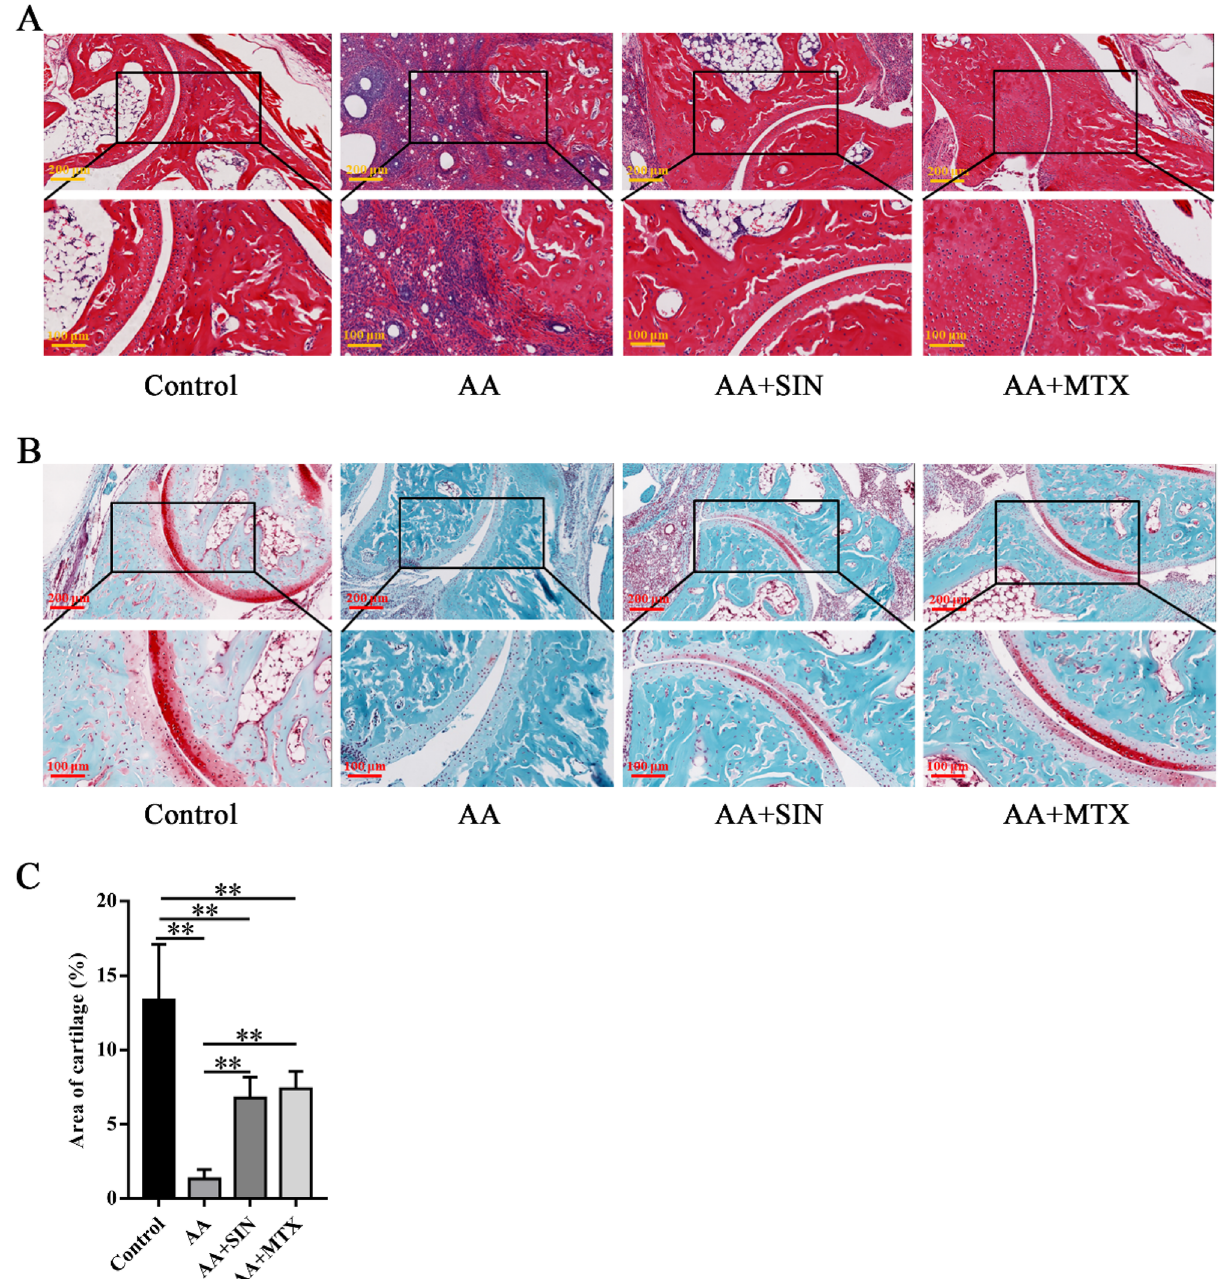
Figure 2. Sinomenine protected bone tissues in AA mice. ( A ) H&E staining of the ankle joint sections from mice in the control group (Control), the model group (AA), the Sinomenine-treated group (AA + SIN) and the methotrexate-treated group (AA + MTX). Representative images are shown. ( B ) Safranin O-fast staining of joint tissue sections from the mice. Representative images are shown. ( C ) Statistical analysis was applied to calculate the cartilage area in ( B ). The data are shown as the mean ± SD (n = 5). *p < 0.05, **p < 0.01 . “n = 5” represents five mice with representative joint diameters and arthritis scores who were selected from each group to prepare ankle joint tissue sections, and one representative picture from each mouse was used for